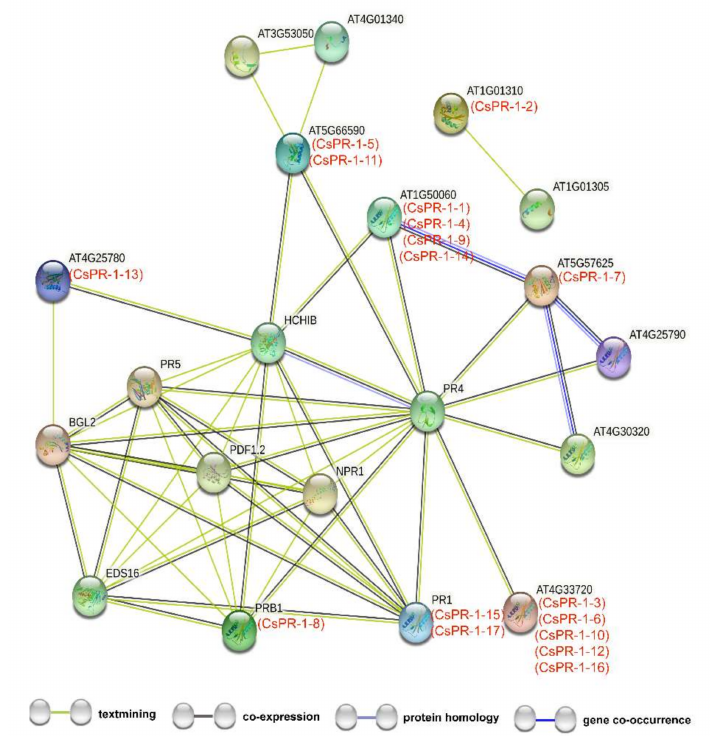
Figure 3. Functional interaction networks of the CsPR-1 protein in the tea plant according to orthologs in Arabidopsis are shown in red and